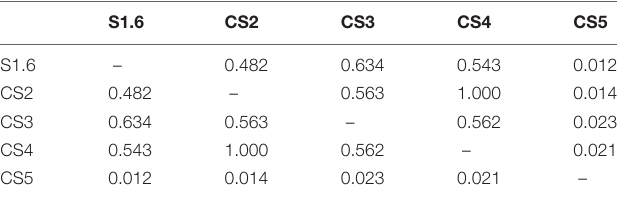
TABLE 6 | The pairwise comparison of V APT of meningiomas ( p- value).